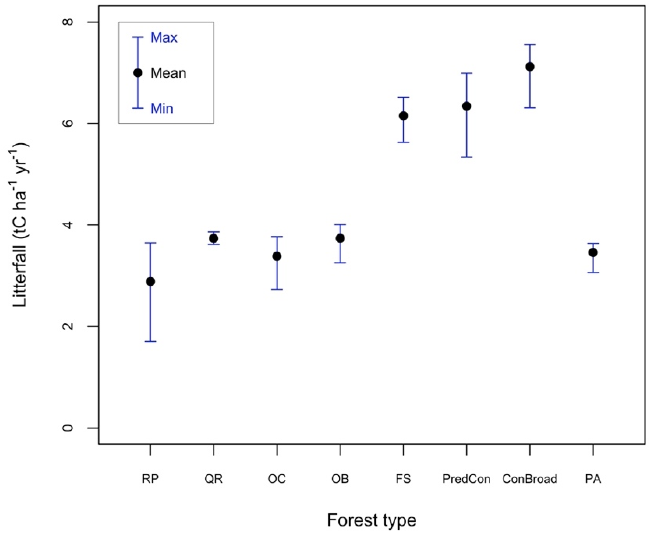
Figure 2. Amount of litterfall (tC ha − 1 yr − 1 ) used for the spin-off (initialization) for each forest type